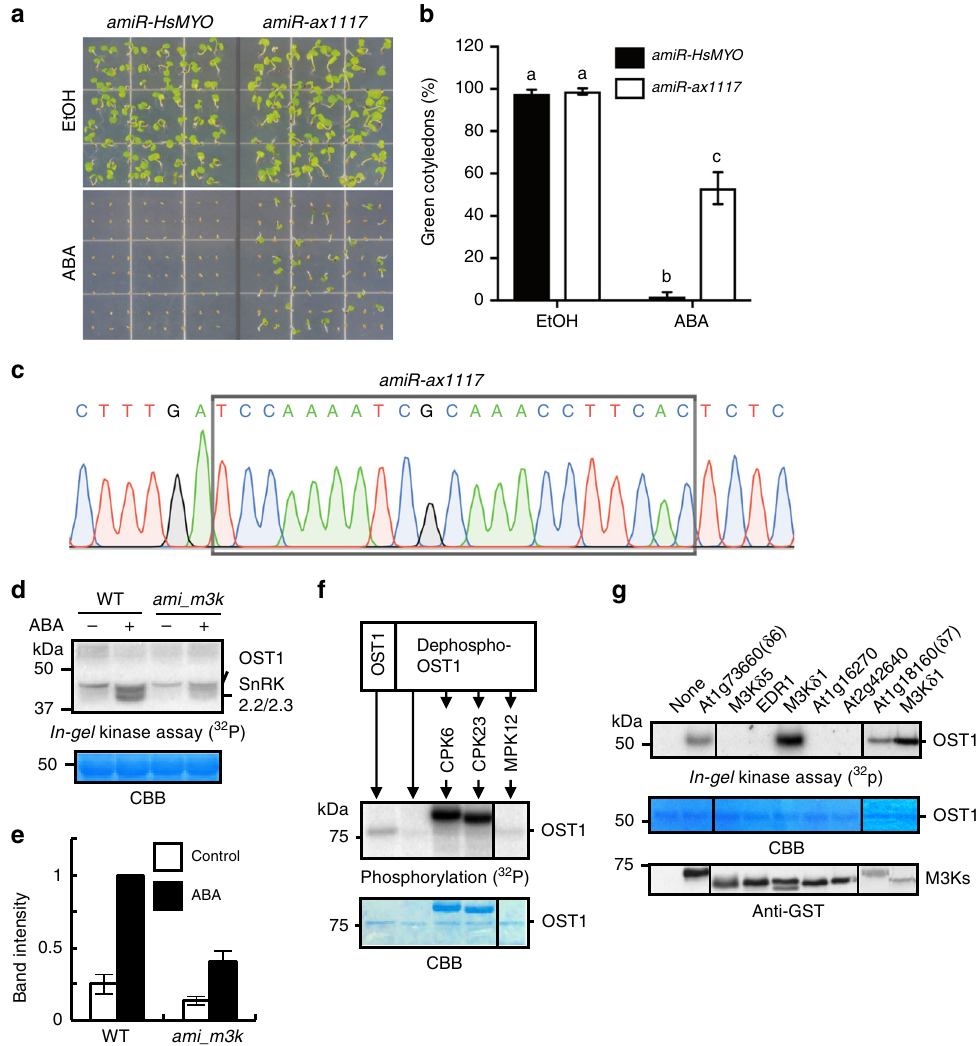
Fig. 1 Identi fi cation of MAPKK-kinases that reactivate OST1/SnRK2 kinases by phosphorylation. a Seeds of amiR-HsMYO wild-type (control line) or amiR-ax1117 mutant were sowed on 1/2 MS medium containing 2 μ M ABA, or 0.02% EtOH as control, for germination assays. Representative images showing seed germination after 6 days. b The percentage of seedlings showing green cotyledons was analyzed. Data represent mean ± s.d. n = 4 experiments. Each experiment included 64 seeds for each genotype. Letters at the top of columns are grouped based on two-way ANOVA and Tukey ’ s test, P < 0.05. c Identi fi cation of the amiRNA sequence in amiR-ax1117 plants. Black box labels the sequence of amiR-ax1117 . The amiR-ax1117 is predicted to include Raf-like protein kinase genes M3K δ 5 , M3K δ 7 , M3K δ 1, M3K δ 6, and M3K δ -CTR1 kinase (see Supplementary Fig. 1). d Wild-type (WT) and m3k amiRNA seedlings were incubated with 10 µ M ABA for 15 min. In-gel kinase assays were performed using histone type III-S as a substrate. e SnRK2 band intensities as shown in d were measured using ImageJ, n = 3 experiments, error bars show ±s.e.m. f , Recombinant GST-OST1/SnRK2.6 protein was dephosphorylated by alkaline phosphatase in vitro and used for in vitro phosphorylation assays after incubation with CPK6, CPK23 or MPK12 protein kinases. Note visible autophosphorylation activity of CPK6 and CPK23. g Dephosphorylated recombinant His-OST1/SnRK2.6 protein was incubated with kinase domains of seven M3Ks and used for in-gel kinase assays (phylogenetic tree: see Supplementary Fig. 1). Note lanes on the left are from the same gel as lanes in the middle